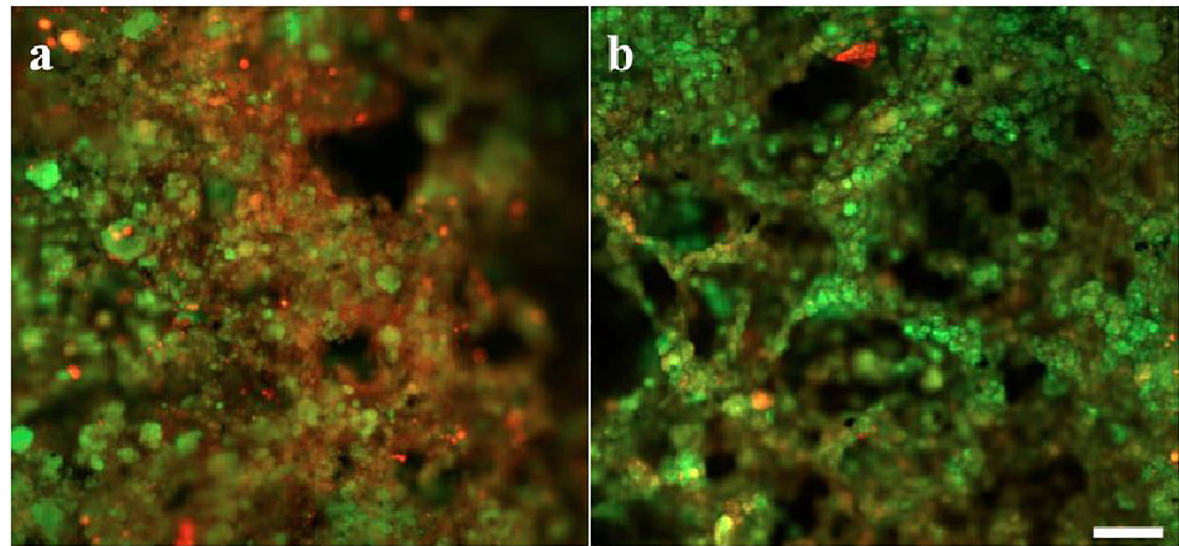
Fig 3. Distribution of live (green) and dead cells (red) in FS IFAS biofilms (a) intact and (b) sloughed biofilm. Scale = 200 μ m.